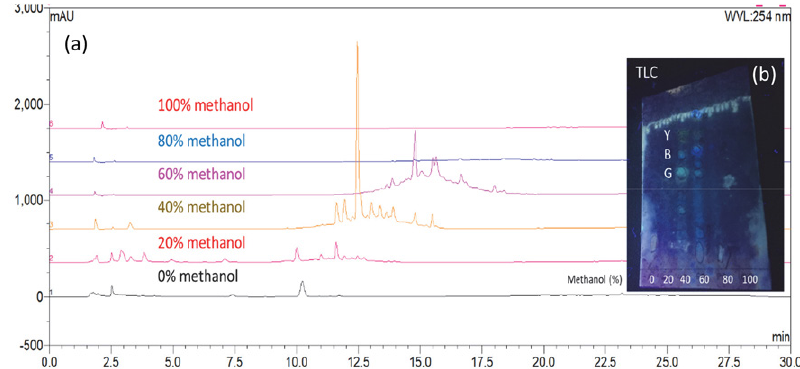
Figure 2. Chromatograms of methanol fractions collected from the elution of Eurycoma longifolia water extract using C18ec cartridges. The com- pound detection was performed using (a) liquid chromatography and (b) thin layer